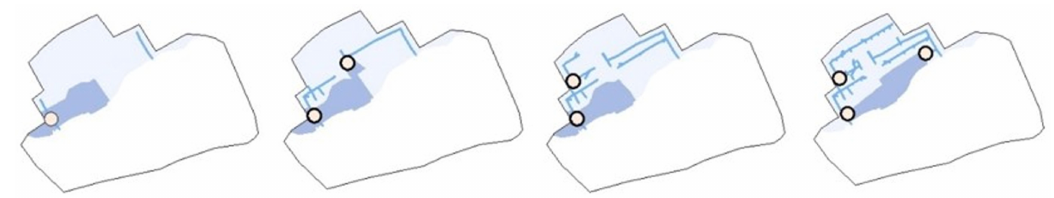
Figure 15. Distribution of the overflow junctions and flood area, flood volume of the overflow junctions, and flood depth of the flood subcatchments for the convention district.